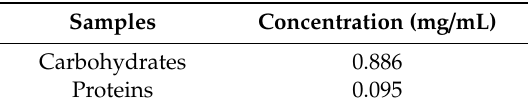
Table 3. Chemical components of the purified